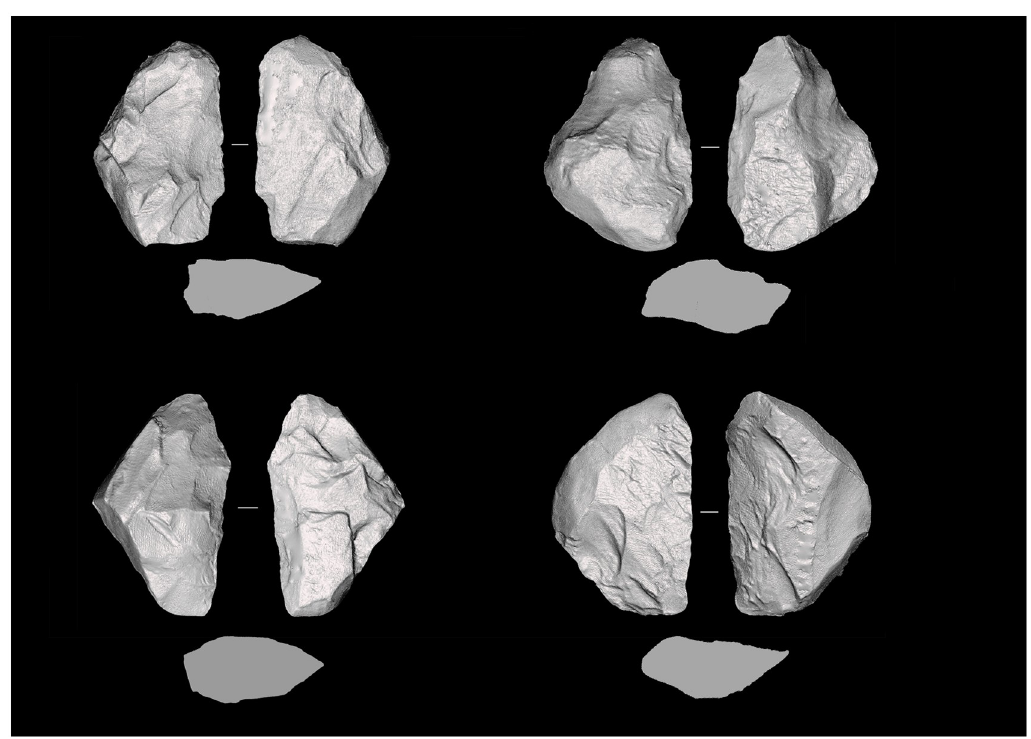
Fig 18. 3D scans of Keilmesser manufactured on lydite or radiolarite pebbles showing the exploitation of the natural convex surfaces for the conception and the obtaining of the back. From the top left: S8890/73; S246/68; P1568/S64; P2965/S65.